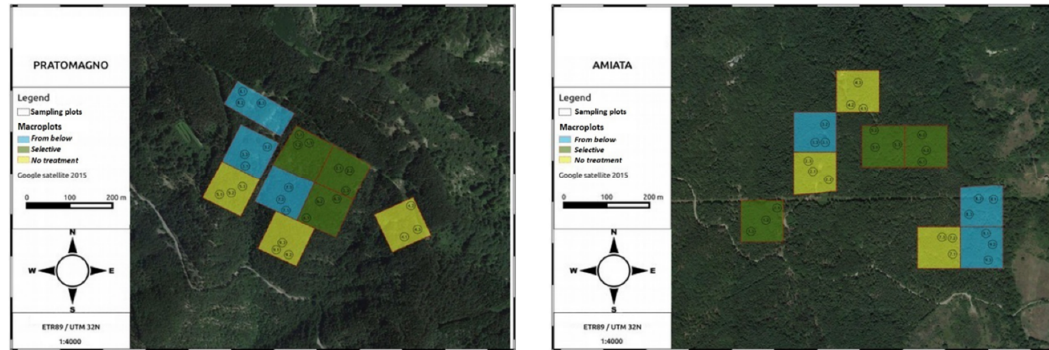
Figure 1. Experimental design in the black pine plantations and macro-plots and sampling plots performed in Pratomagno and Amiata sites.